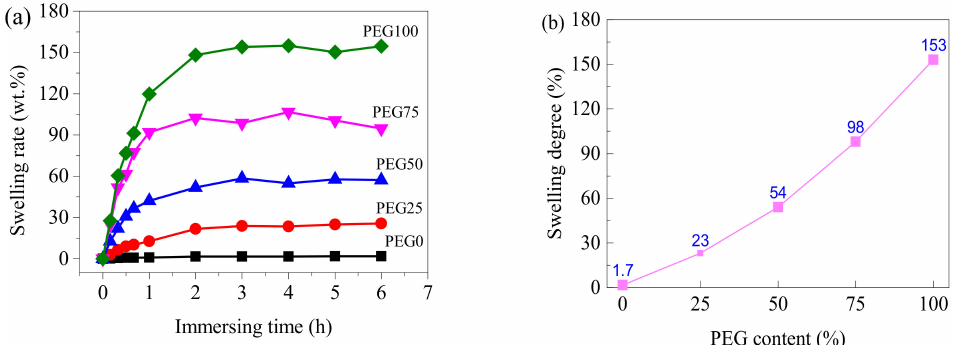
Figure 4. Swelling behavior of the PEG-PU films in seawater. ( a ) swelling rate with time; ( b ) swelling degree with PEG content.